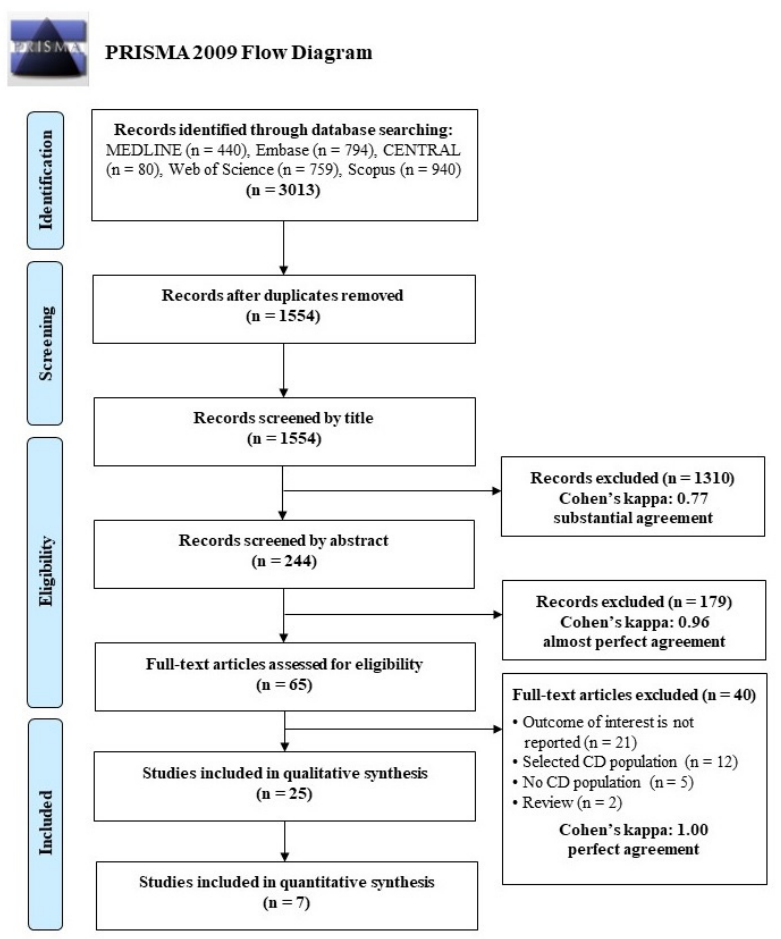
Figure 1. PRISMA flow chart describing the process of the study search and selection .